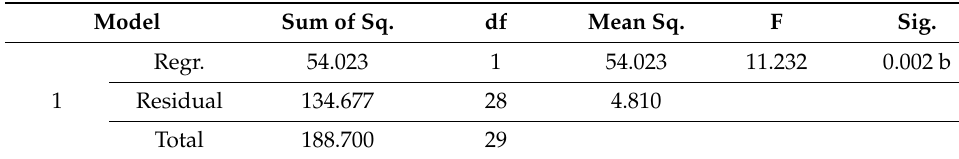
Table 6. E-court use and user performance. Model Sum of